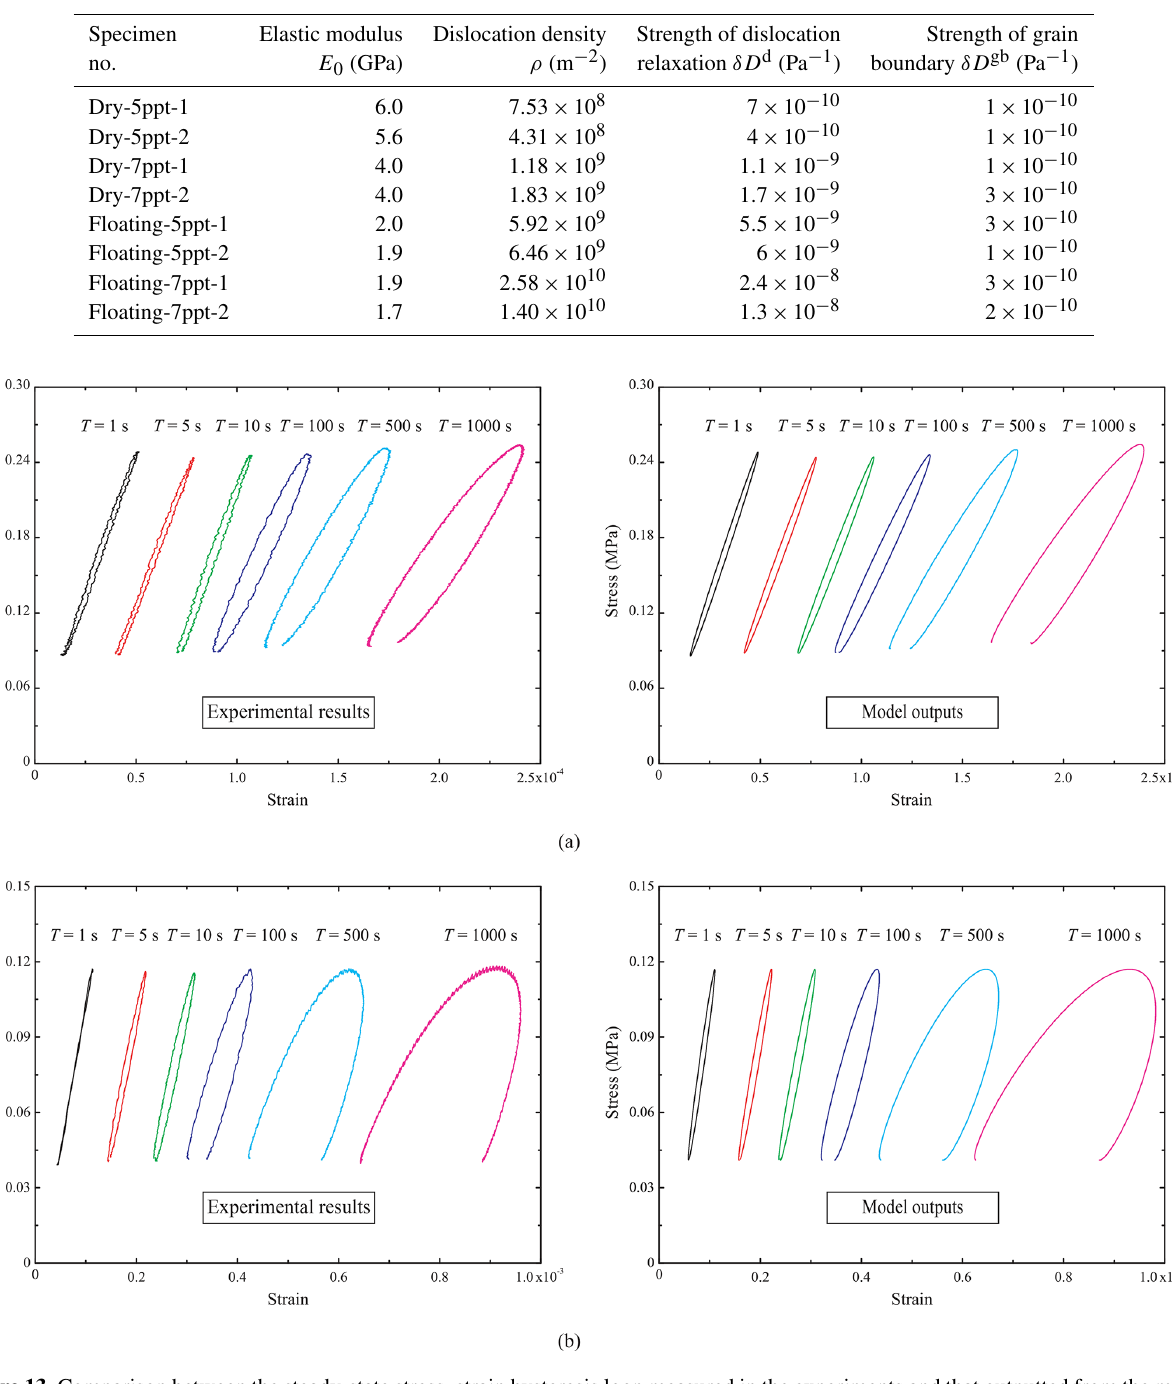
Table 4. Values of the model parameters calibrated for simulating the strain response of the ice specimens (in Sect. 5, these values are discussed and compared to those reported in the references).